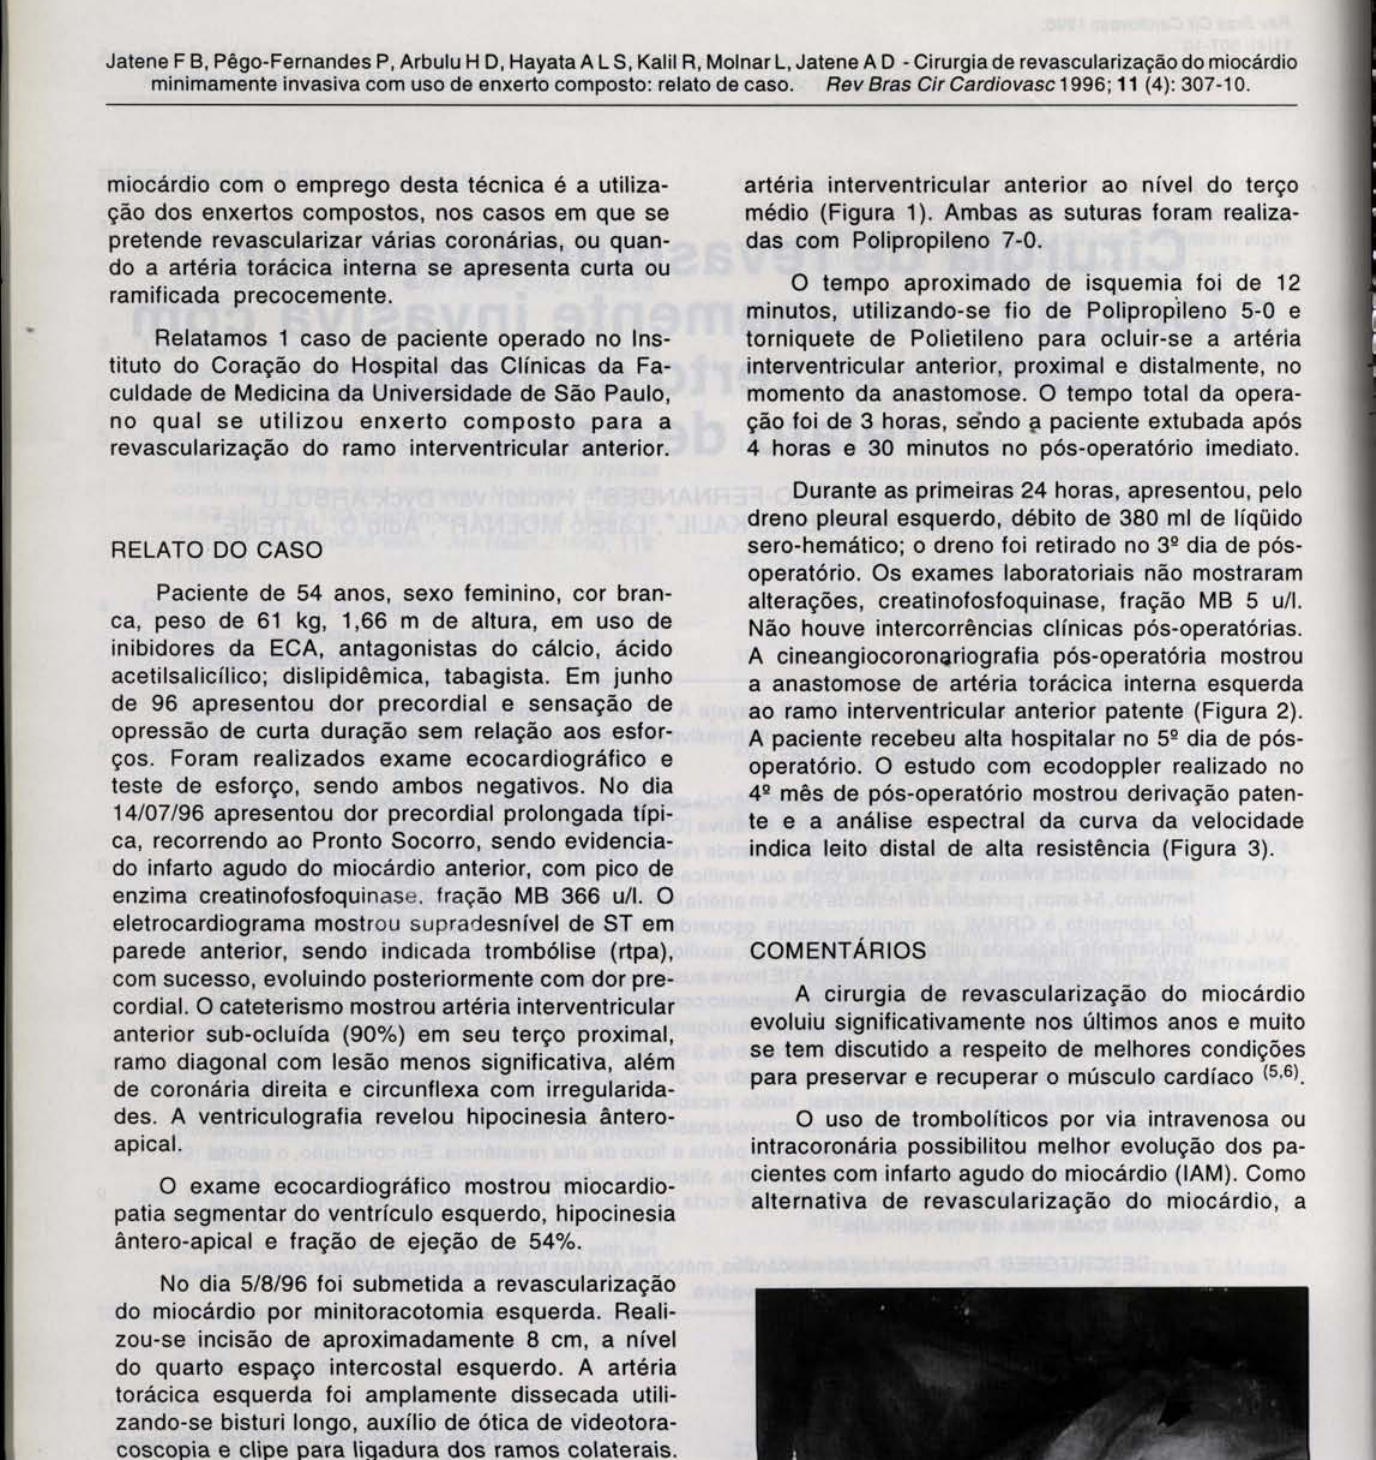
Fig. 1 - Detalhe do campo operatório, observando·se segmento de safena anastomosado à artéria interventricular anterior e anastomose entre a safena e a artéria torácica interna